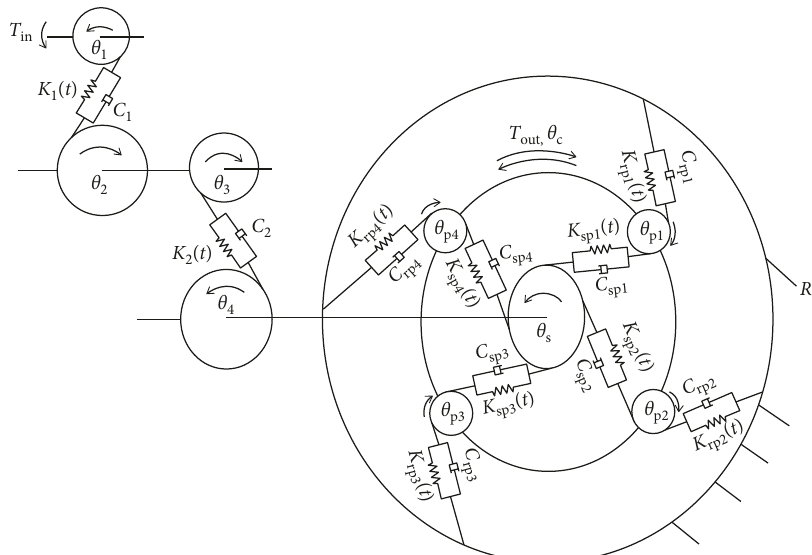
Figure 1: Torsional dynamic model of the multistage gear transmission system [18] (reproduced from Wang [18] (under the creative commons attribution license/public